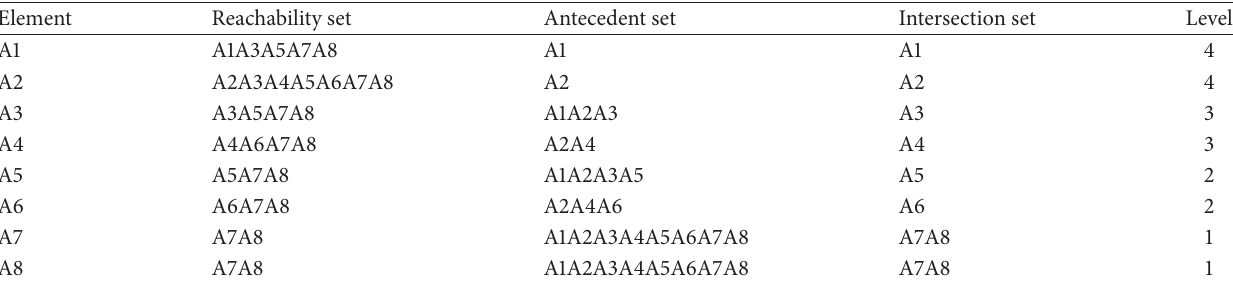
Table 3: Levels of model 1 elements.